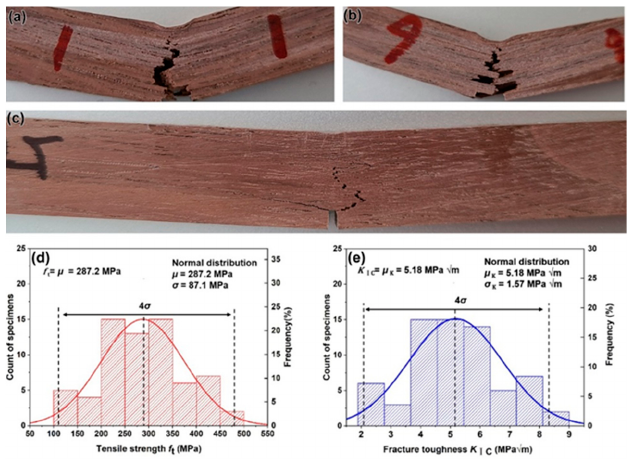
Figure 5. ( a – c ) Side views of the failed samples, and the normal distribution of the tensile strength ( d ) and fracture toughness ( e ) of BW.